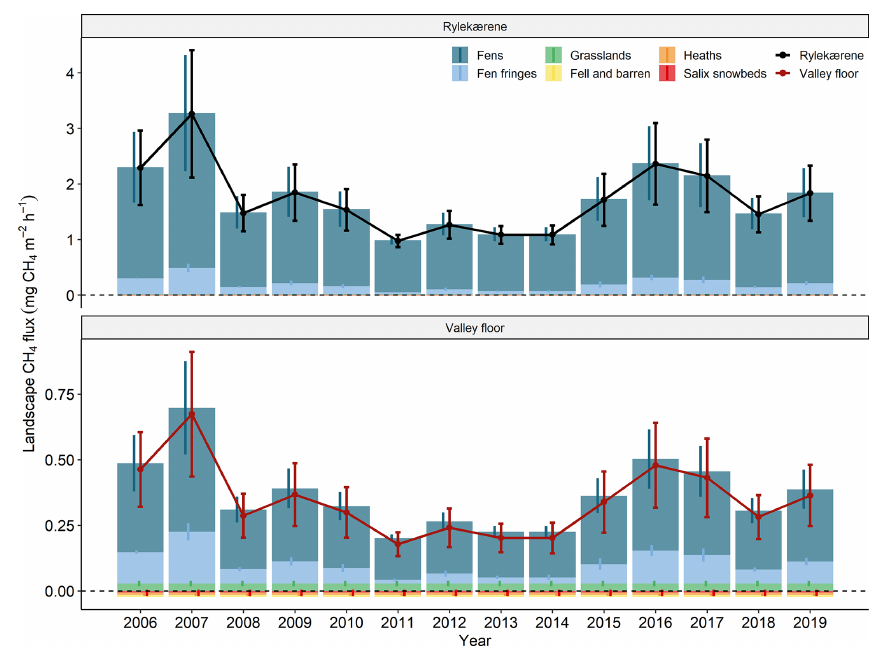
Figure 6. Cumulative fluxes and SE from the six surface classes are shown for the two areas. Fluxes and SE from each surface class are weighted to their relative coverage and shown with stacked bars. The fen and fen fringe fluxes are predominant in the calculation of both landscape fluxes, explaining the nearly identical pattern in interannual